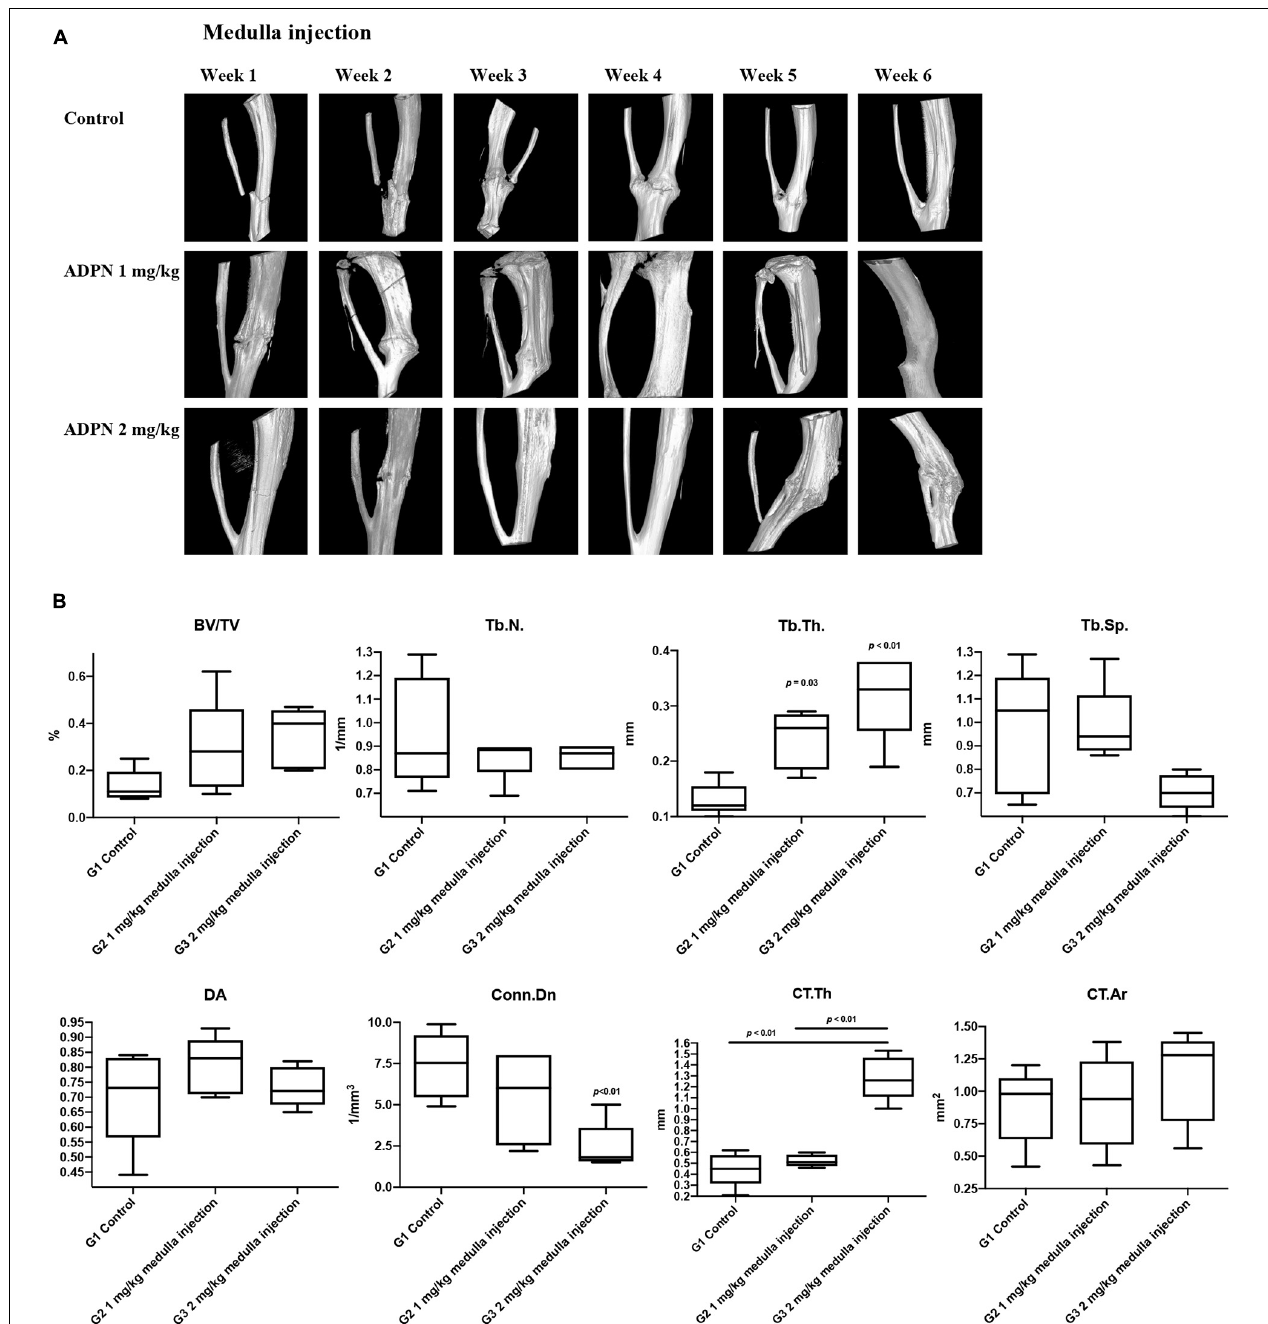
FIGURE 3 | Local medulla injection of ADPN accelerated fracture healing and significantly influenced bone microarchitecture. (A) The three-dimensional µ CT reconstruction of rat tibia from week 1 to 6. (B) Bone morphometric indices extracted from microcomputerized tomography ( µ CT) at week 6, n = 6.